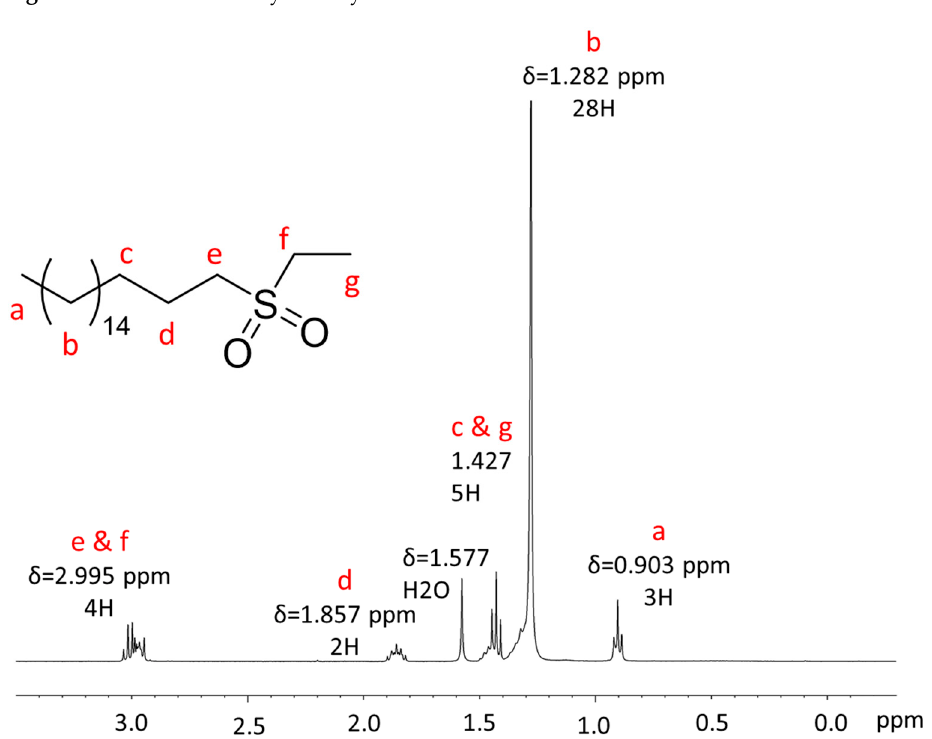
Figure Figure A4. 1 H NMR of ethylsulfonyloctadecane. Figure A4. 1 H NMR of ethylsulfonyloctadecane.